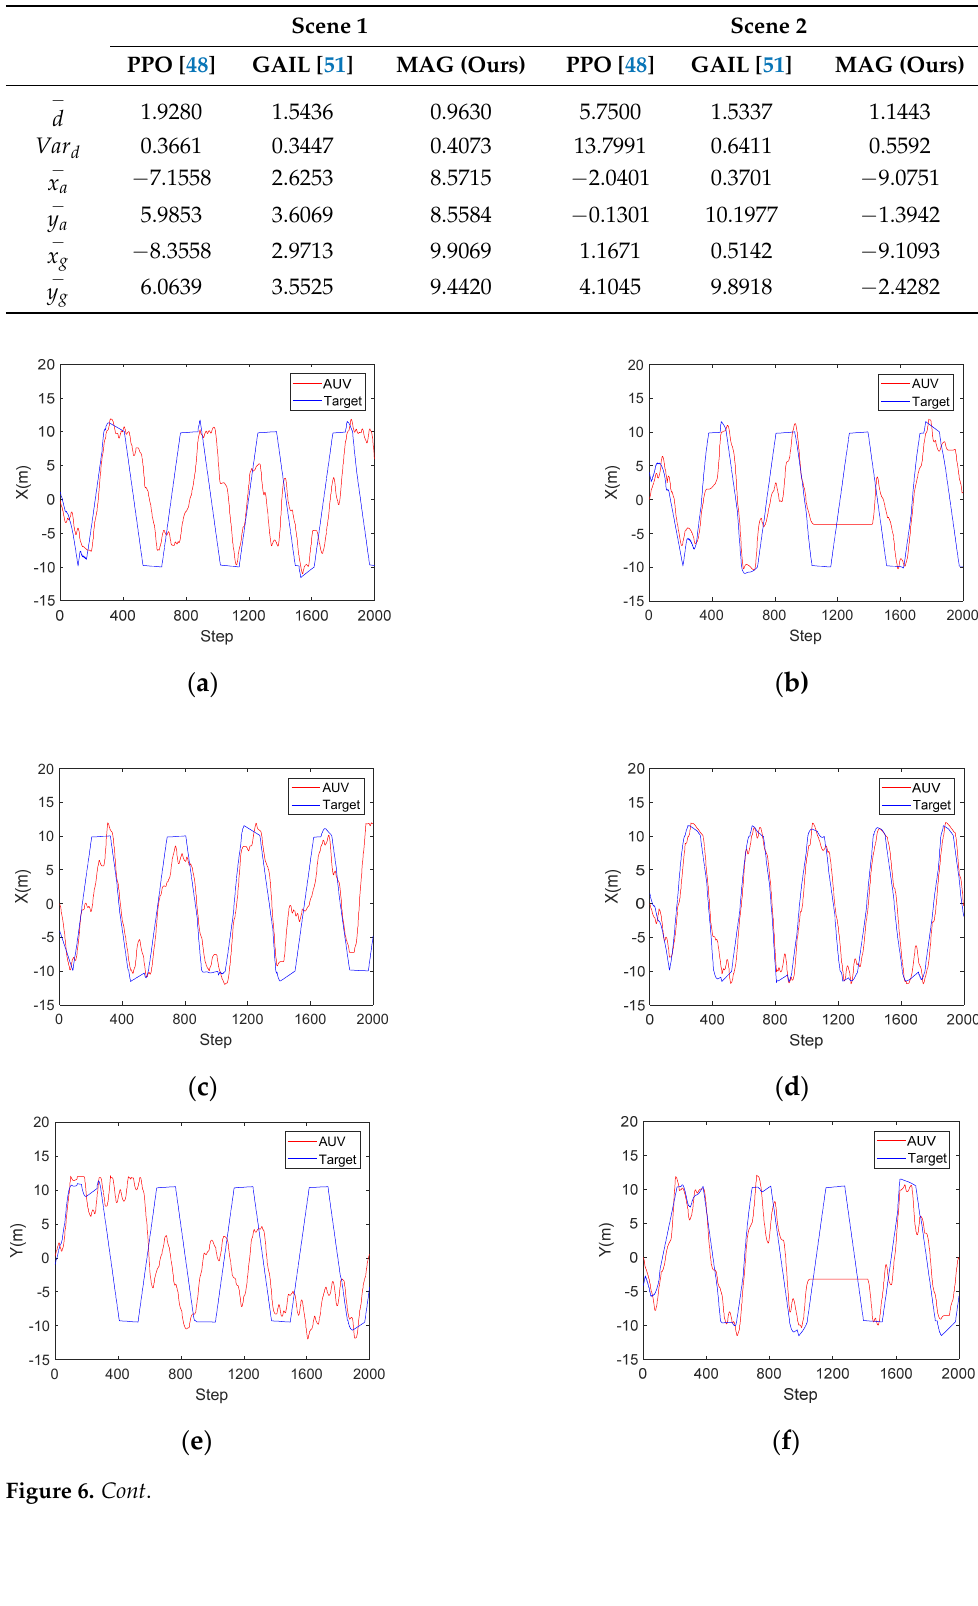
Table 3. Comparison of tracking performance after AUV training 100,000 times using PPO, GAIL, and MAG in Scenes 1 and 2.